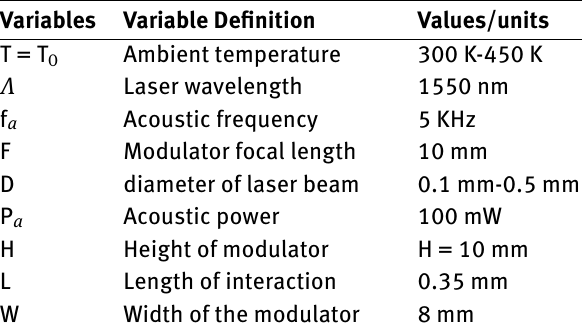
Table 1: Variables for the acoustic optic modulators